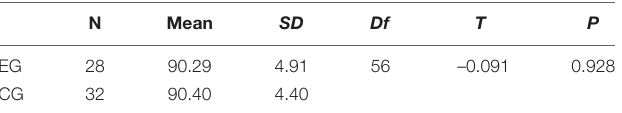
TABLE 3 | Independent samples t -test of midterm test scores in the experimental group (EG) and the control group (CG).